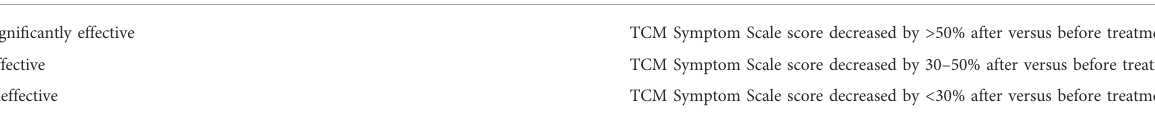
TABLE 1 Treatment ef fi cacy according to TCM Symptom Scale Score. Effect level De fi nition